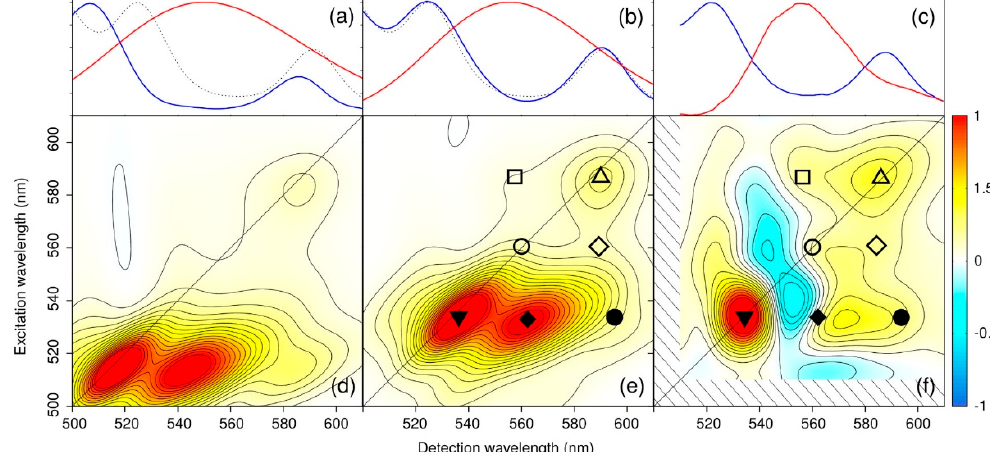
Figure 4. Comparison of simulated ( d , e ) and experimental ( f ) 2DES pump-probe maps of Rps. acidophila at 300 K and waiting time t 2 = 22 fs. The corresponding linear absorptions (blue) and pulse shapes (red), along with the relative experimental linear spectra (dashed line), are reported in ( a – c ), respectively. In the calculated maps the pulse shape was adapted to have the same overlap between pulses and absorption bands as the one reported in the experiments. Panel ( e ) refers to a calculated map where Car S 2 site energies and Q x transition dipoles have been scaled to match the position and the intensities measured in the linear spectrum. Simulated maps are normalized to their maximum. By convention, bleach and stimulated emission contributions appear as positive (red) signals, excited state absorption appears as negative (blue) peaks. Full (referring to Cars) and empty (referring to BChls) geometric symbols are used to indicate correlations between calculated and measured signals. Reprinted with permission from [62]. Copyright (2017) American Chemical Society.